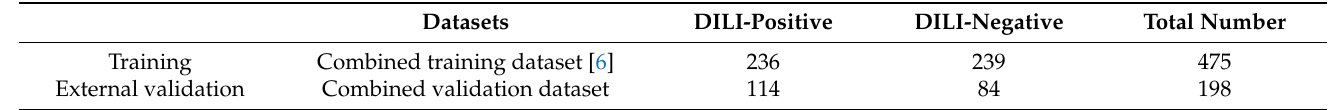
Table 3. Summary of datasets used in the external validation study.